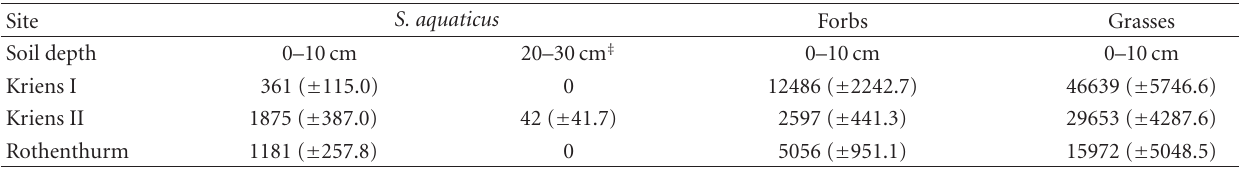
Table 1: Means ( ± SE; n = 9) of germinable seeds of Senecio aquaticus , forbs, and grasses m − 2 in the soil at three grasslands with established populations of S. aquaticus located in the centre of the geographical distribution of the species in Switzerland. Site S. aquaticus Forbs Grasses Soil depth 0–10 cm 20–30 cm